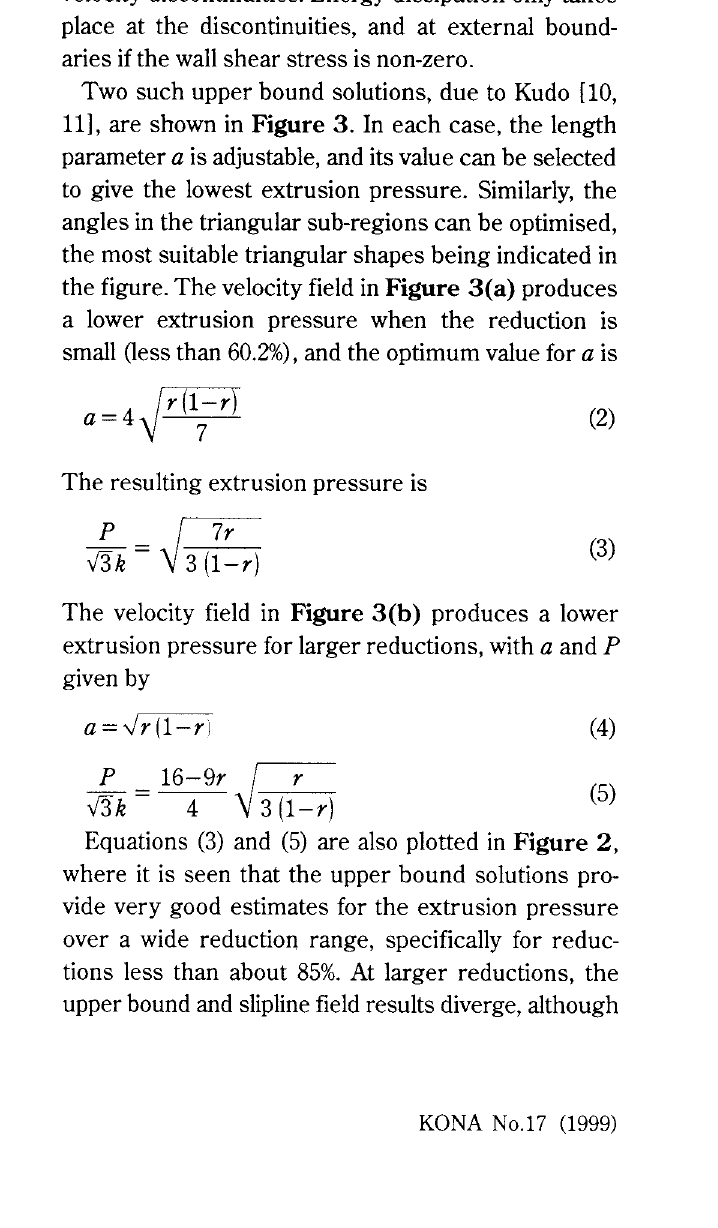
Extrusion pressures for plane strain extrusion through smooth, square-entry